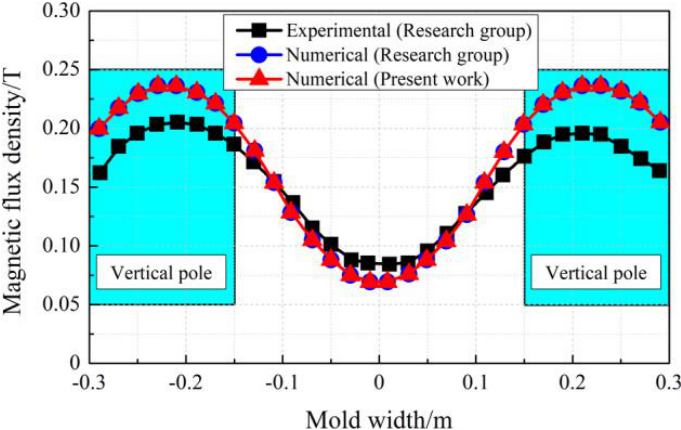
Figure 8. Distribution of magnetic flux density along the mold width direction.